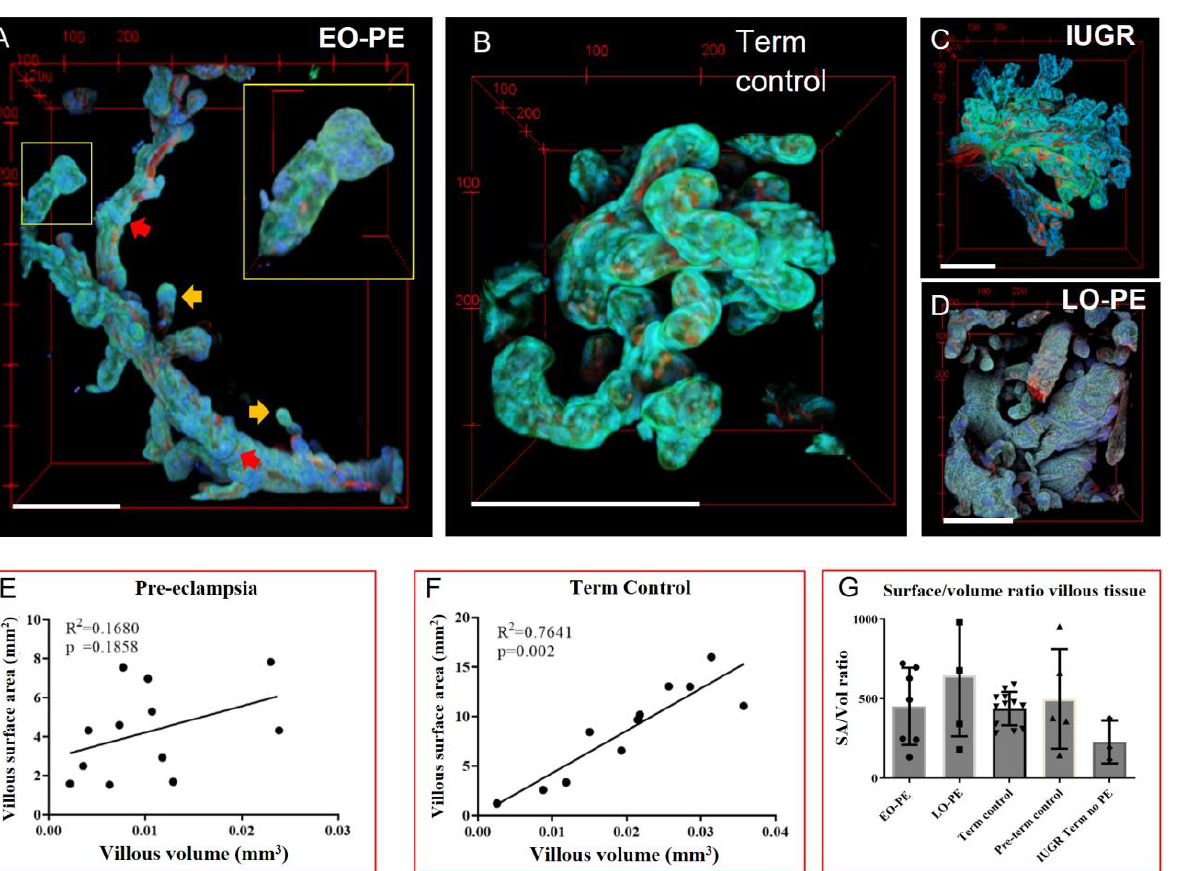
Figure 3. MPM imaging of villous morphology and surface and volume quantification. ( A ) EO-PE placenta had long slender villi. The inset indicates a paddle-like villous ending which was not uncommon for EO-PE. ( B ) Term control terminal villi stem branching off. Villi appear more condensed, more branched and shorter compared to EO-PE. ( C ) IUGR placenta displayed highly branched villi. ( D ) LO-PE illustrating numerous stem villi. ( E ) Villous volume and surface area of pre-eclampsia placenta was quantified and non-linearly related. PE data was pooled together ( n = 12 images of 2 placentas). ( F ) Villous surface area and volume were linearly related in quantified term control villi ( n = 11 images, of 3 different placentas). ( G ) Ratio of villous surface area over volume. No clear trend is observed. Green — villous outline, blue — nuclei, red — vascular stain. Red-arrows — (wave-like knots. Yellow arrows — sprouts. Results are presented as means ± standard deviation. Scale bars — 200 μm.